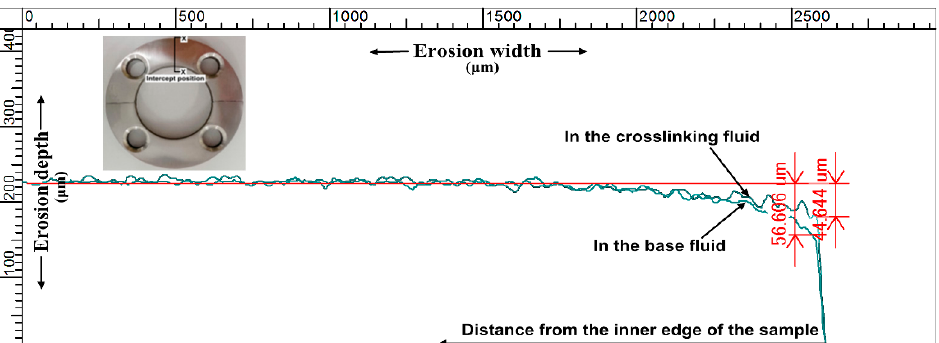
Figure 7. Distribution of particles in different fluids, ( a ) dispersed particles in the base fluid; ( b ) particle clusters in the crosslinking fluid.